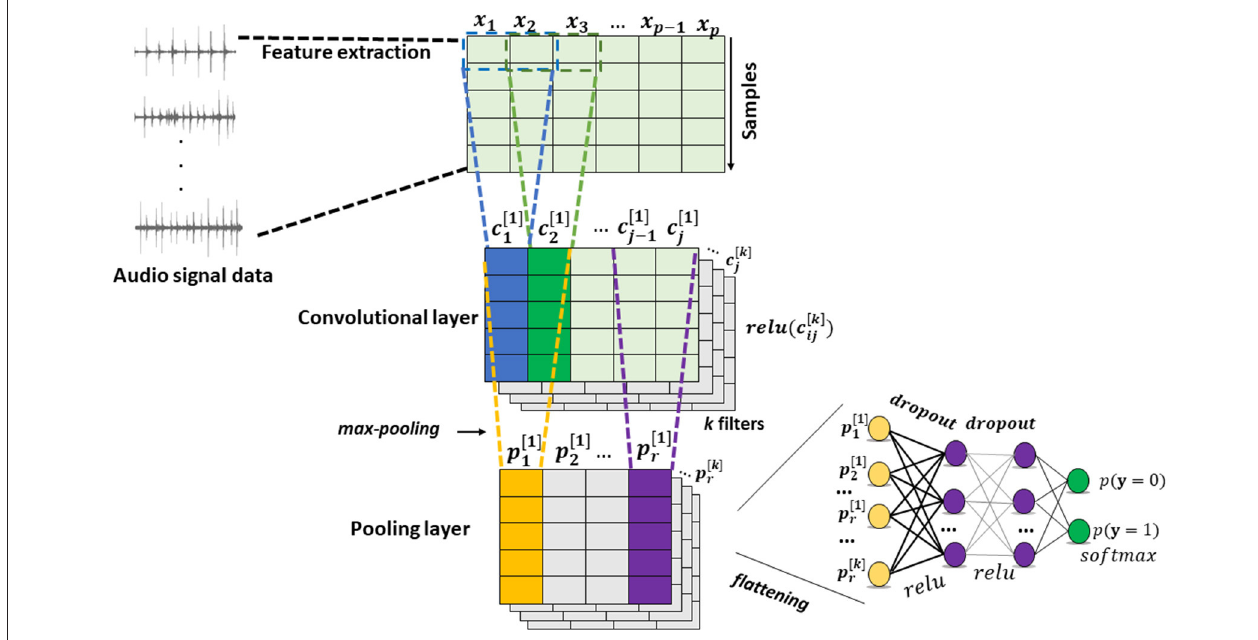
FIGURE 3 | Schematic representation of the used 1D CNN general architecture. The input layer receives the audio-based features data that were extracted from raw audio-signal; the convolutional layer is composed of k filters; each filter captures information in the input data by performing local operations involving a limited number of input features depending on the filter size (filters of size 2 are represented) and moves toward the input data space according to the stride size (stride size = represented); the pooling layer operates by converting the outputs of the convolutional layer at some certain locations into a single value by taking its maximum (max-pooling operation); the last layer is a fully-connected multilayer perceptron that receives flatten pooling layer outputs as input